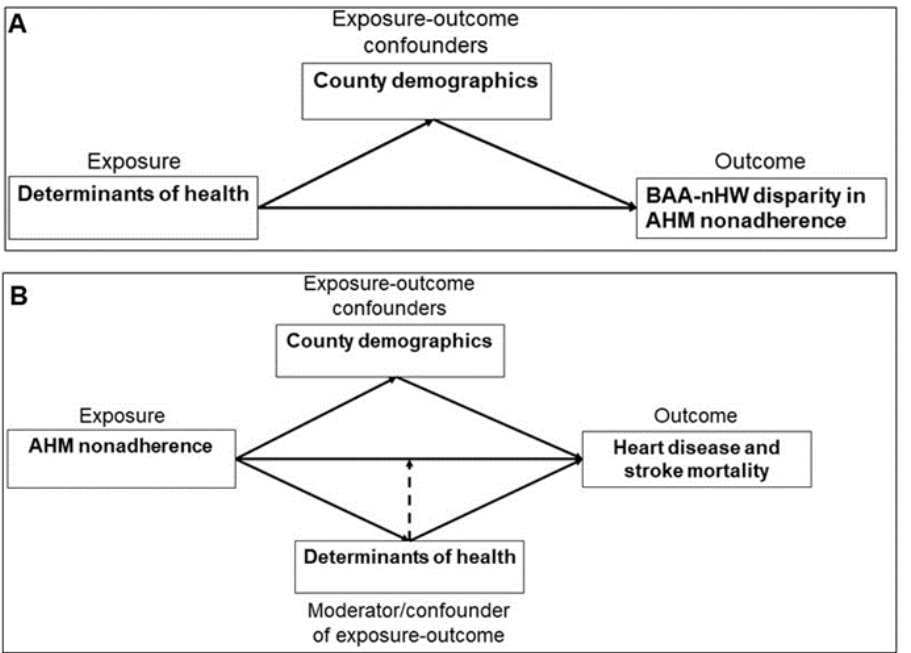
Figure 1. Conceptual models for accessing determinants of health as contributors of the BAA–nHW disparities in AHM non-adherence ( A ) and as potential moderators of the associations between AHM non-adherence and heart disease and stroke mortality ( B ). Solid arrows represent confounding effects while the dashed arrow represents moderating effects.